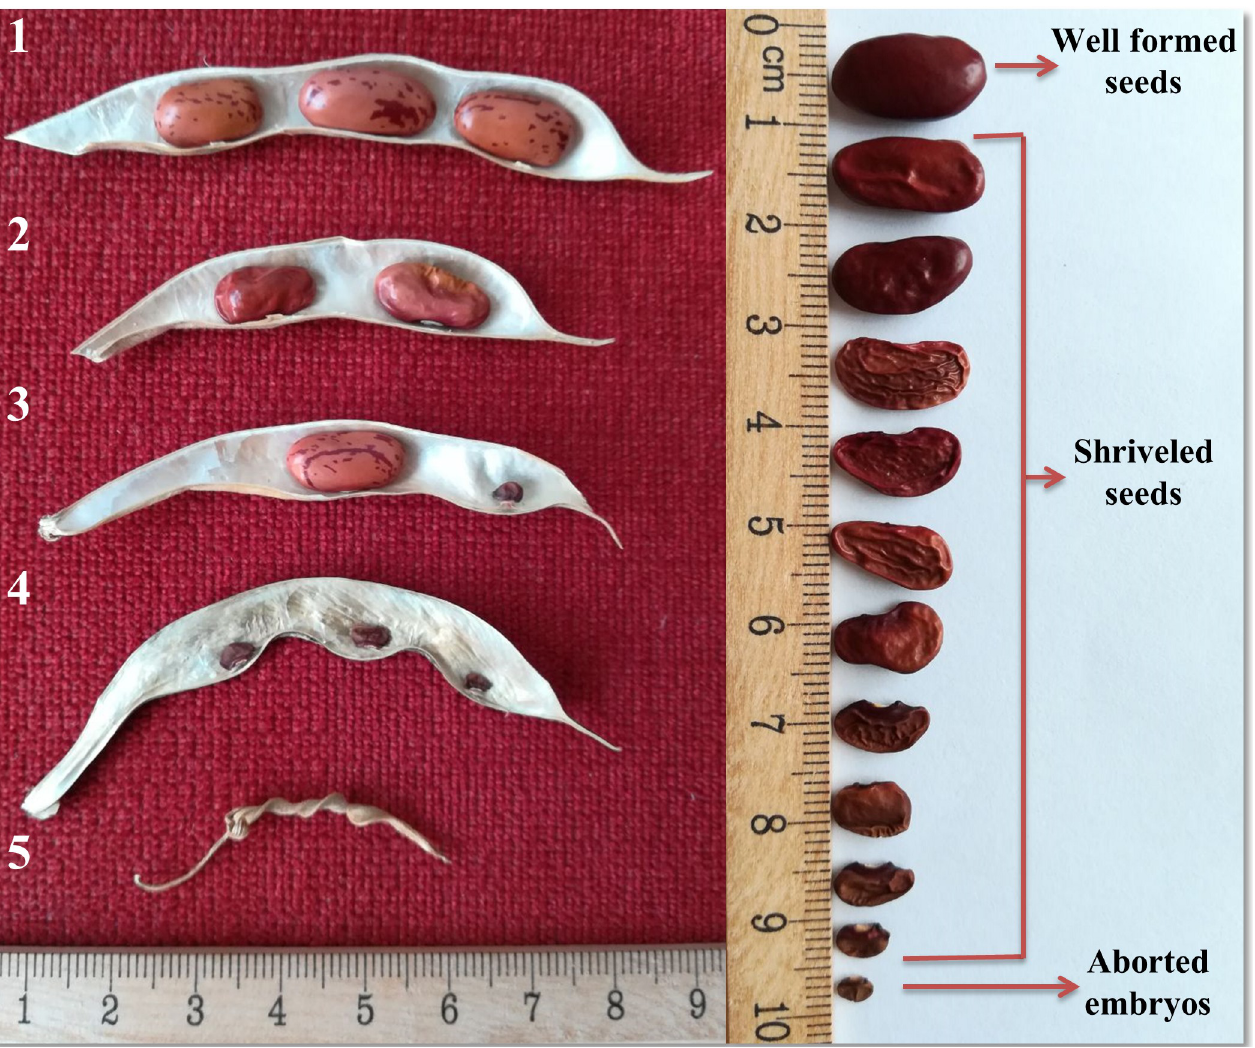
Fig 2. Classification of pods according to the seed characteristics. 1: Pods with well-formed seeds (PdWF); 2: Pods with shriveled seeds (PdShr); 3: Pods with partially well-formed seeds (PdPWF); 4: Pods with aborted embryos (PdAE); 5: Pods that are empty (PdE). On the right the range of seed formation defects that was observed in the heat stress trials is